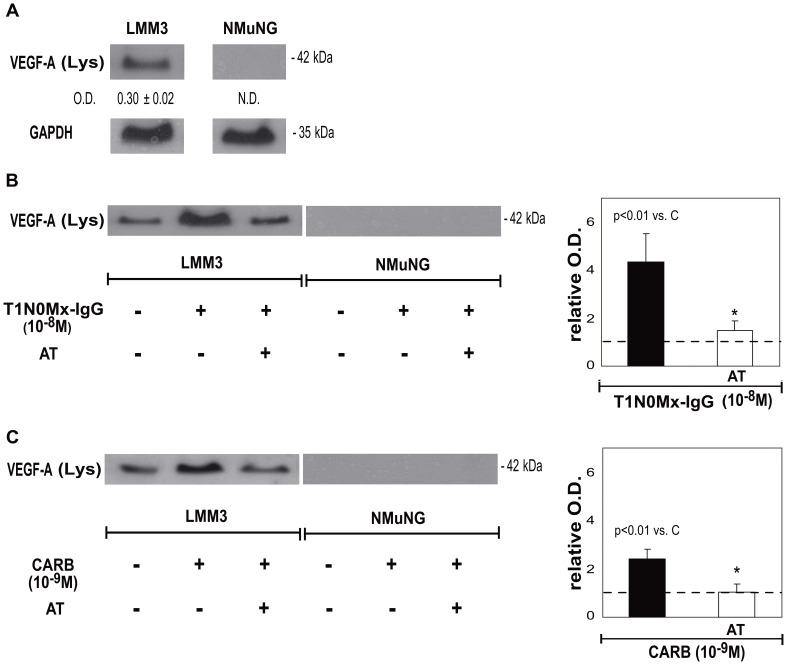
Effect of T1N0Mx-IgG on VEGF-A expression in murine tumor cells.A) LMM3 and NMuMG cell lysates (Lys). Optical density (O.D.) of the bands was calculated by densitometric analysis, and values were relativized to the expression of glyceraldehyde-3-phosphate dehydrogenase (GAPDH). N. D. not detectable. One representative experiment of three is shown. Values are mean±S.E.M. Molecular weights are indicated on the right. LMM3 cells were treated with B) T1N0Mx-IgG or C) carbachol (CARB) in the absence or presence of 10−8 M atropine (AT). Densitometric analysis of the bands is shown in the right pannel. Values were relativized to the expression of VEGF-A in LMM3 cells without treatment considered as 1, and is represented by a dotted line. Values are mean±S.E.M. of three experiments. *p<0.01 vs. T1N0Mx-IgG or CARB. Molecular weights are indicated on the right.